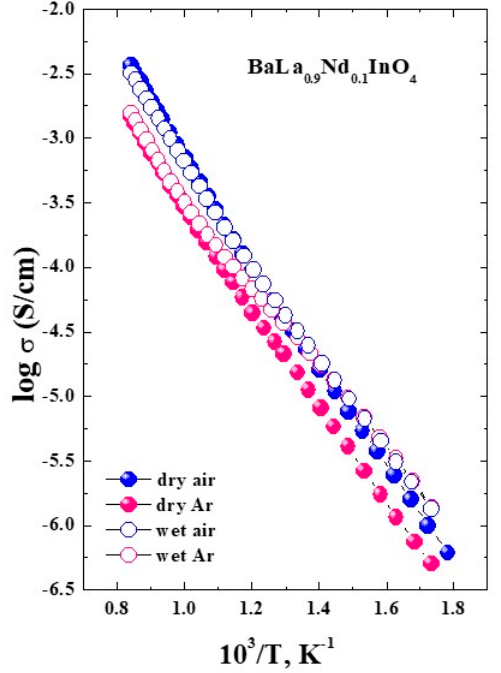
Figure 7. The conductivity dependencies form temperature for BaLa 0.9 Nd 0.1 InO 4 composition. The relation of conductivity at wet air (open blue symbols) and at wet Ar (open red symbols) is different in comparison with dry condition. At high temperatures (higher than 450 ◦ C), the conductivity values in wet air are higher compared to values in wet Ar. At low temperatures (below 450 ◦ C), the conductivity in wet air is comparable with the conductivity in wet Ar. Because proton concentration becomes significant at low temperatures,